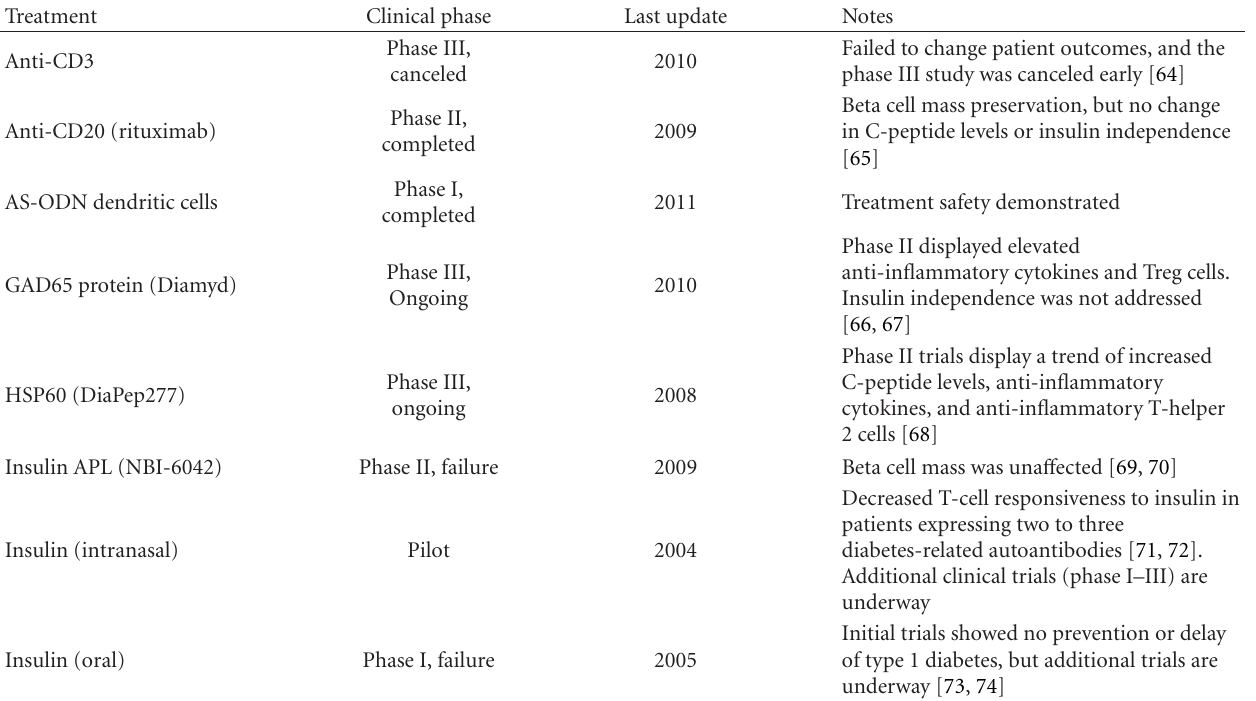
Table 2: Clinical trial history for the immunomodulatory treatment of type I diabetes and current